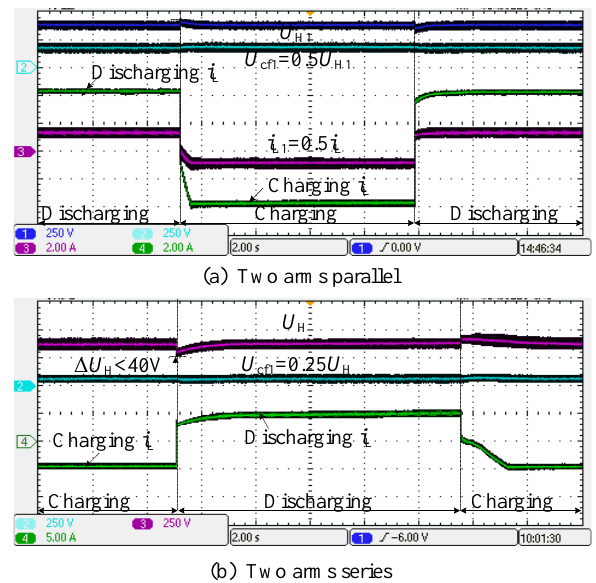
Figure 10. Two arms complementary series. ( a ) Boost mode, ( b ) Buck mode.